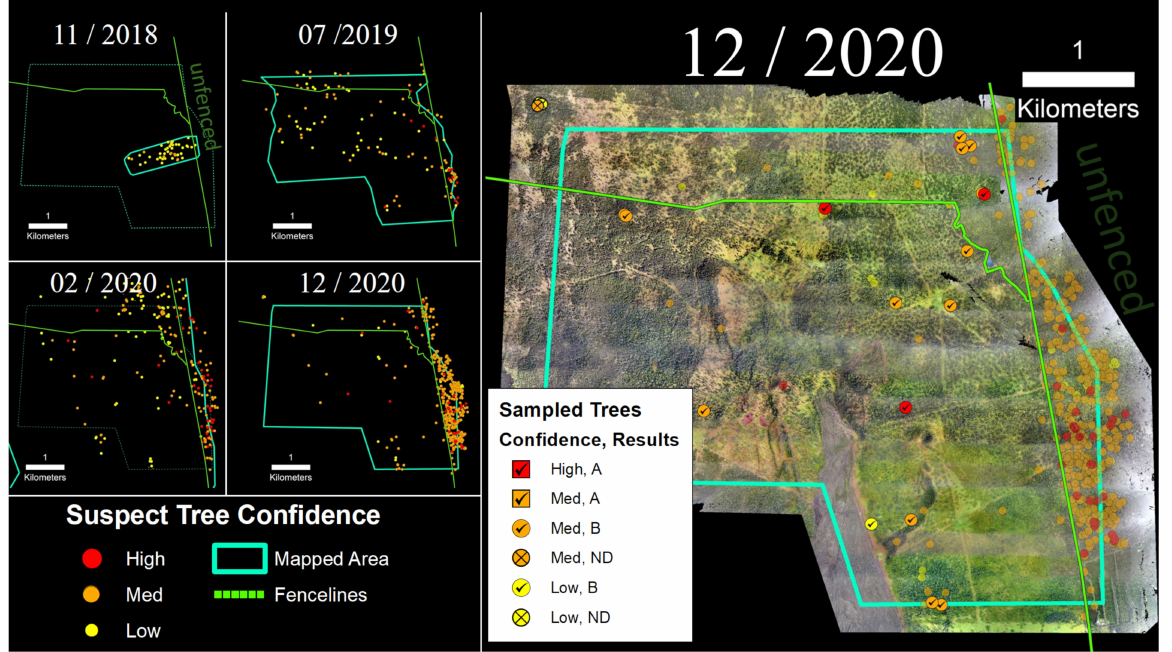
Figure 7. ( Left ) Time-series sequence of suspect trees for a portion of the Kahuku Unit of Hawai‘i Volcanoes National Park. ( Right ) Sampled trees and corresponding laboratory results; non-sampled suspect trees appear as semi-transparent background